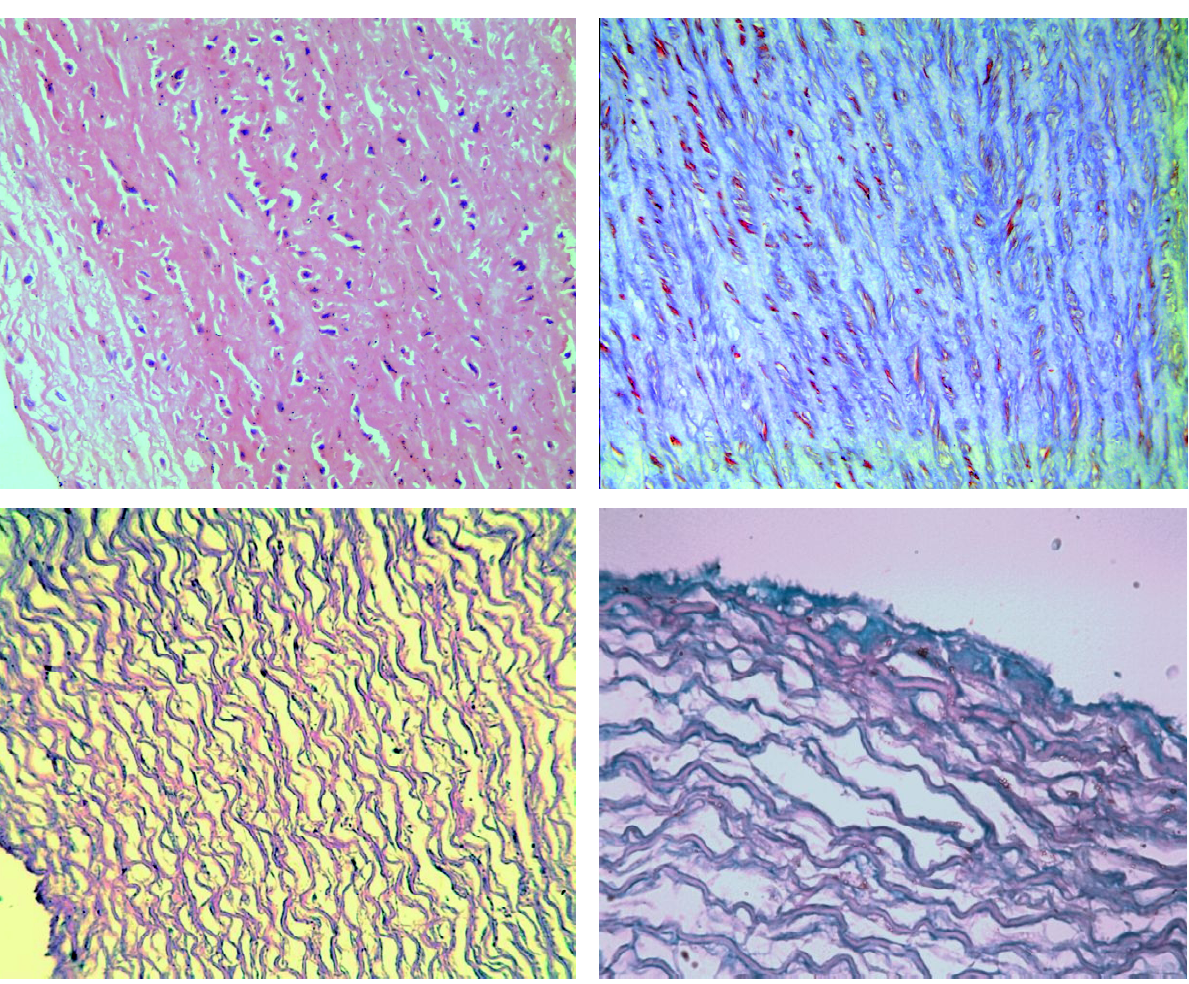
Fig. 1 – Histological appearance of the aortic media and intima within the normal structures of a healthy subject. (A) The aortic wall structures were intact, the intima was intact and the smooth muscle cells were abundant. H&E×400; (B) The normal aorta had very few collagens. Masson×200; (C) The normal aorta had intact and regular arrayed elasitic fibers in the intima and media. van Gieson×400; and (D) Very few acid mucopolysaccharides were deposited in the normal aorta.